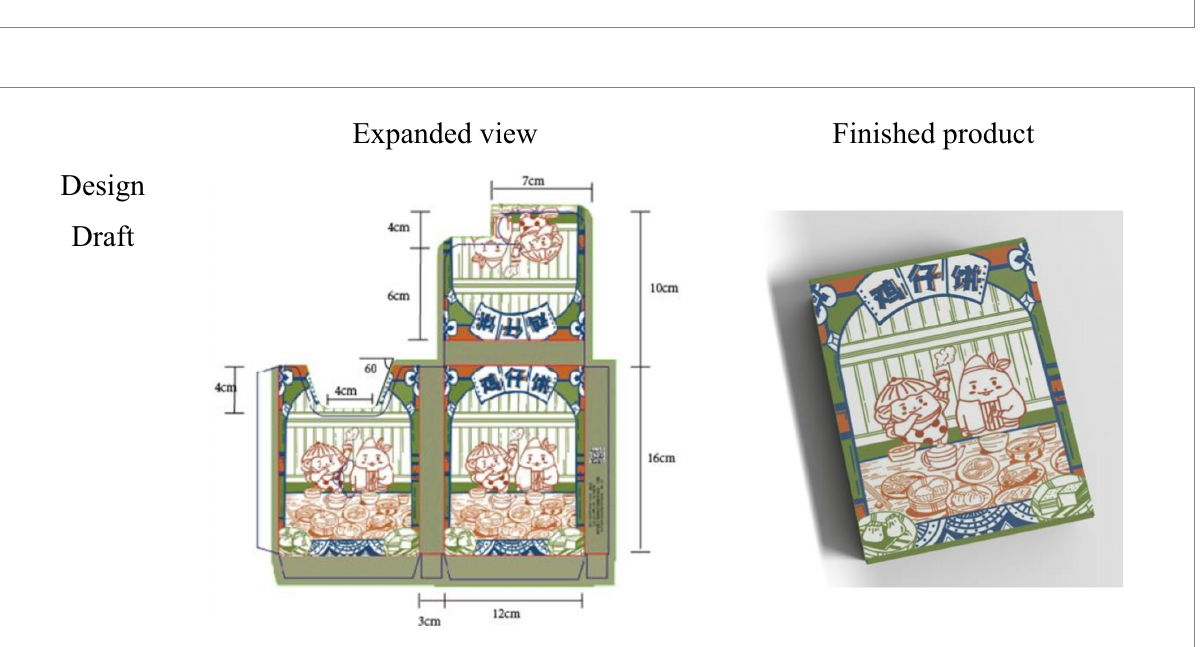
FIGURE 5 Chicken pie packaging design.